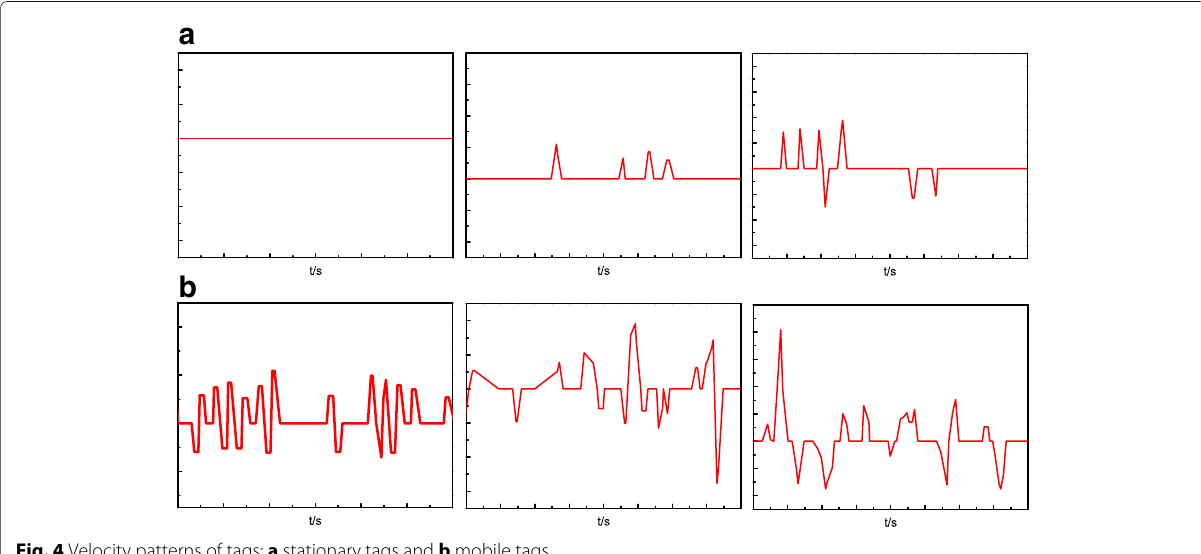
Fig. 4 Velocity patterns of tags: a stationary tags and b mobile